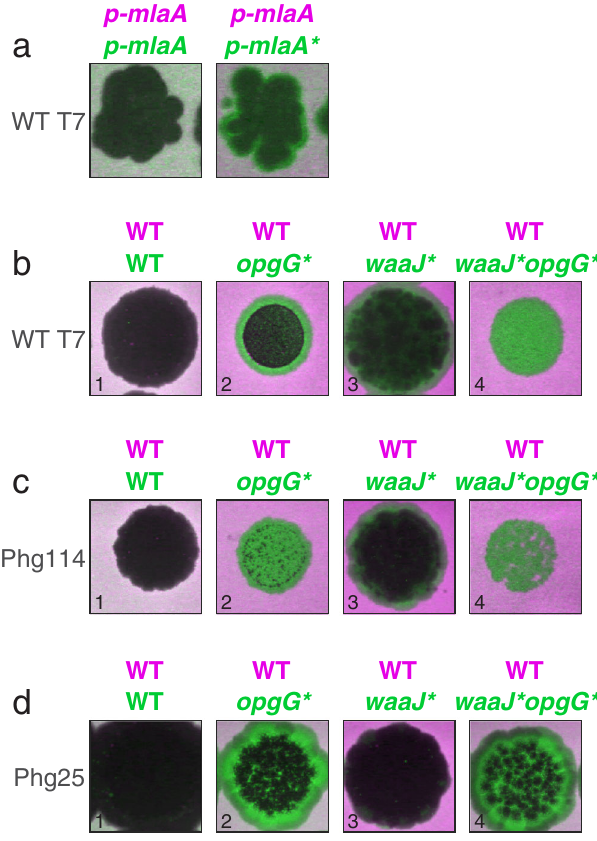
Fig.4|Reconstructingmutationsin opgG or mlaA providesT7resistancealone and in interaction with a mutation in LPS biosynthesis. a A two-color plaque assaywiththewildtypeT7phage(WTT7)spottedonamixtureofYFPandmCherry tagged wildtype bacterial strains carrying a plasmid expressing either mlaA wild- type (p- mlaA ) or mlaA mutant (p- mlaA *) genes 56 . Left: a control with both strains expressing the wildtype mlaA ; Right: a strain expressing mlaA * and tagged YFP (green) has a small selective advantage over a strain expressing the wildtype mlaA (taggedmCherry,magenta),manifestingasagreenhaloattheborderoftheplaque zone(Methods:Two-colorplaqueassay). b An opgG mutanthasamildT7resistance advantageoverthewildtype (compare panelb2versuswild-type control, panelb1) and strong synergy with the waaJ mutation (compare double mutant in panel b4 versus singlemutants in panelsb2,b3). c , d Unlike inresistanceto the wildtypeT7, whencompetedinthepresenceoftwochosenevolvedT7phages(Phg114, c Phg25, d See genotypes in Supplementary Data 4 and infectivity phenotypes in Supple- mentary Data 5), the opgG mutation provides strong resistanceboth alone (c2, d2) and when combined with the waaJ mutation (c4, d4), indicating phage-speci fi c advantage of this